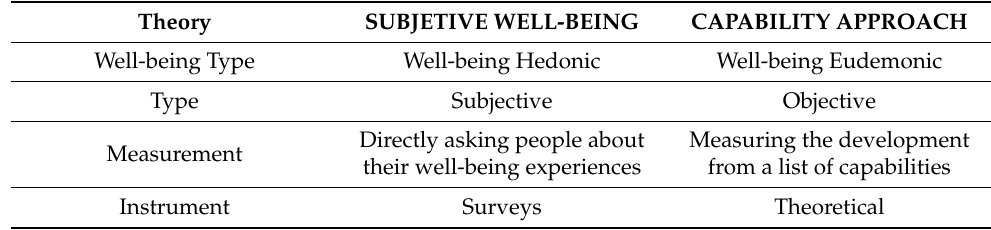
Table 1. Differences between two well-being theories. Theory SUBJETIVE WELL-BEING CAPABILITY APPROACH Well-being Type Well-being Hedonic Well-being Eudemonic Type Subjective Objective Directly asking people about Measuring the development Measurement their well-being experiences from a list of capabilities Instrument Surveys Theoretical Source: Own